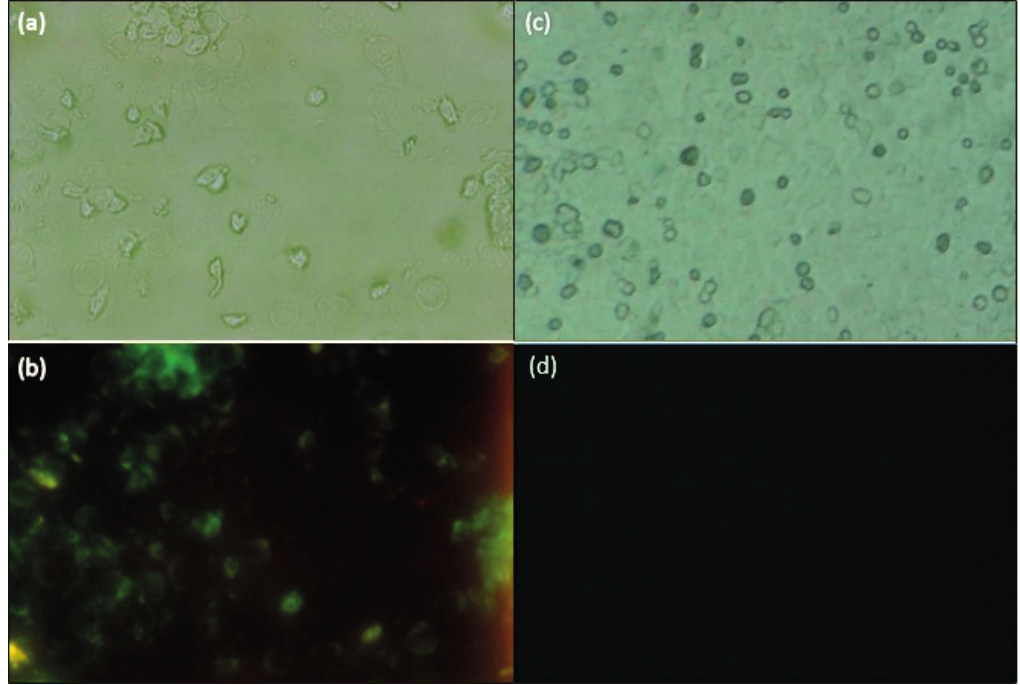
Figure 5. Fluorescence microscopy results: HCT 116 cell lines ( a ) prior and ( b ) after UV light; HEp-2 cell line ( c ) before and ( d ) after UV exposure (Olympus Fluorescence Microscope Model BX50, 40× magnification, Tokyo,